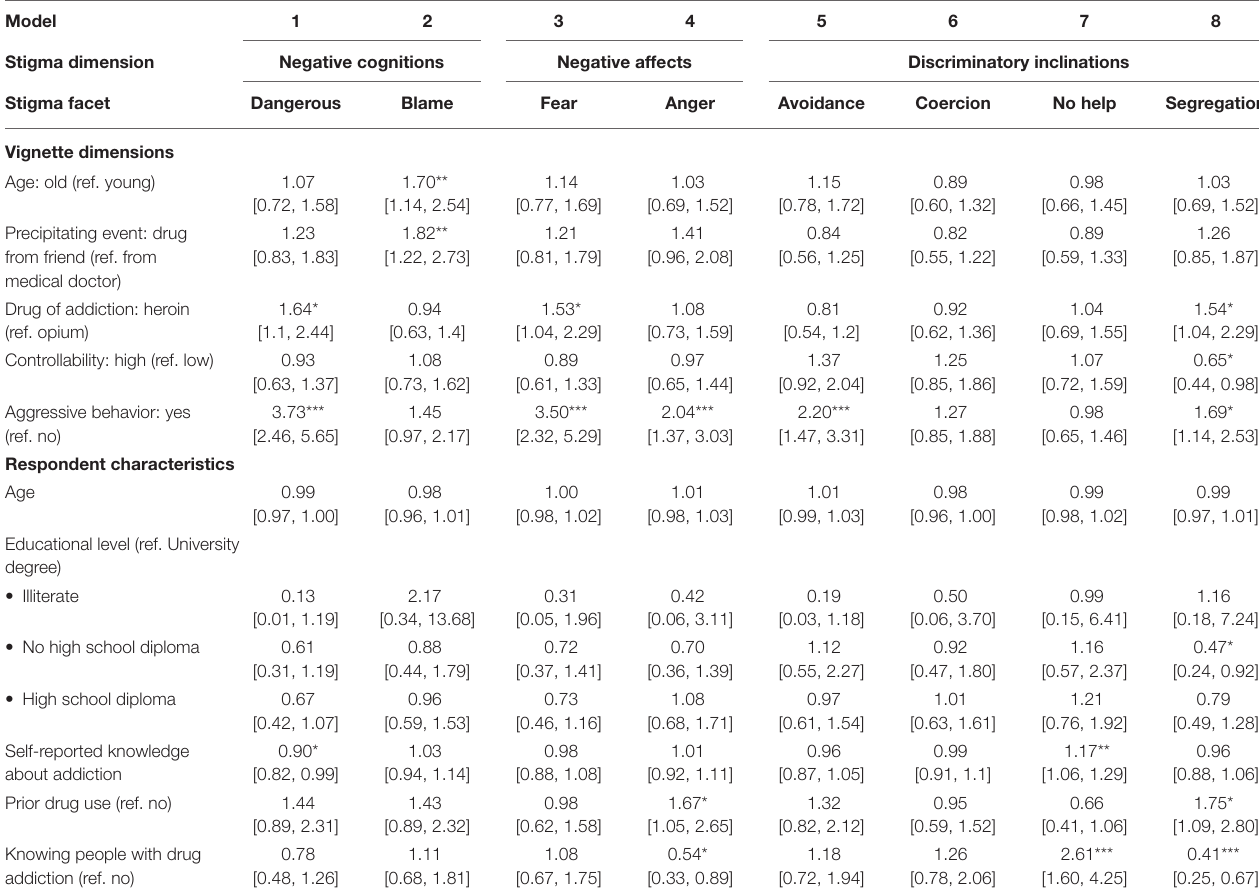
TABLE 3 | Multivariate ordered logit regression models † on the Attribution Questionnaire (AQ) for women ( N = 320), with EM-imputation. Model Stigma dimension Negative cognitions Negative affects Discriminatory inclinations Stigma facet Dangerous Blame Fear Anger Avoidance Coercion No help